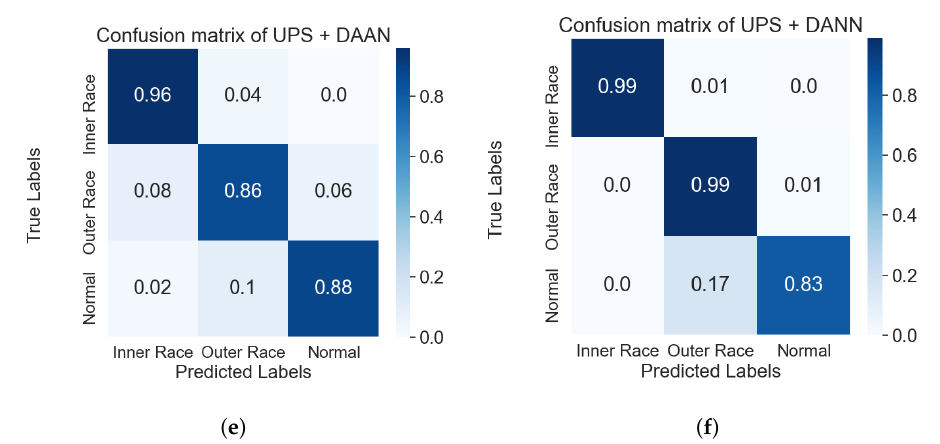
Figure 8. Confusion matrices of different models: ( a ) confusion matrix of baseline, ( b ) confusion matrix of DAAN, ( c ) confusion matrix of DANN, ( d ) confusion matrix of UPS, ( e ) confusion matrix of UPS + DAAN, and ( f ) confusion matrix of UPS +